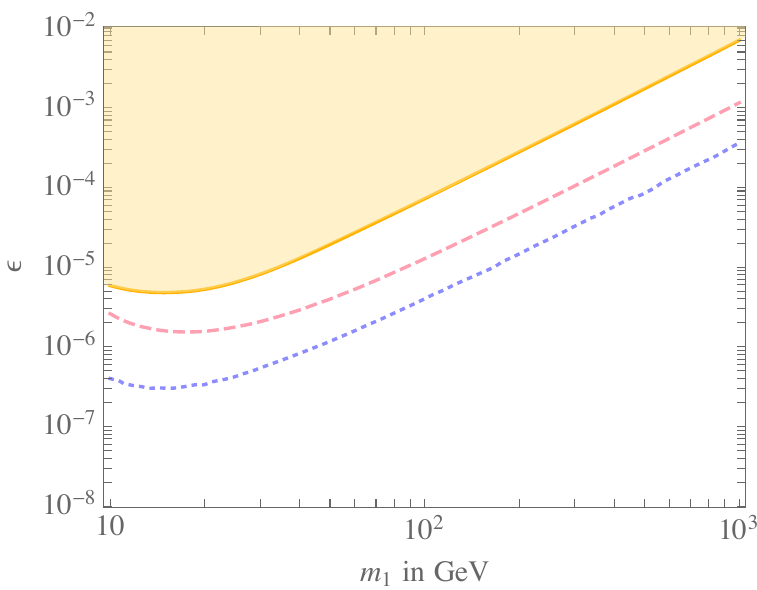
Figure 3 . Direct detection bounds on the kinetic mixing parameter ε as a function of the dark matter mass m 1 . We set a = 1 / 2 and fixed α D such that the thermal relic abundance of dark pions reproduces the correct DM density. The solid yellow line corresponds to the spin-independent bound set by Xenon1T, while the pink dashed and purple dotted lines are respectively the projected sensitivity of the LZ experiment and the neutrino